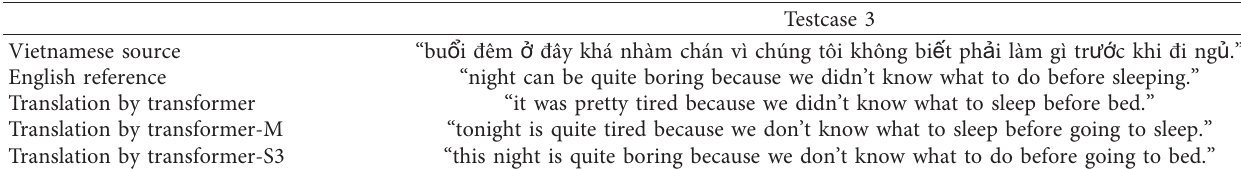
Table 9: Translations of a Vietnamese sentence comprising 20 tokens.